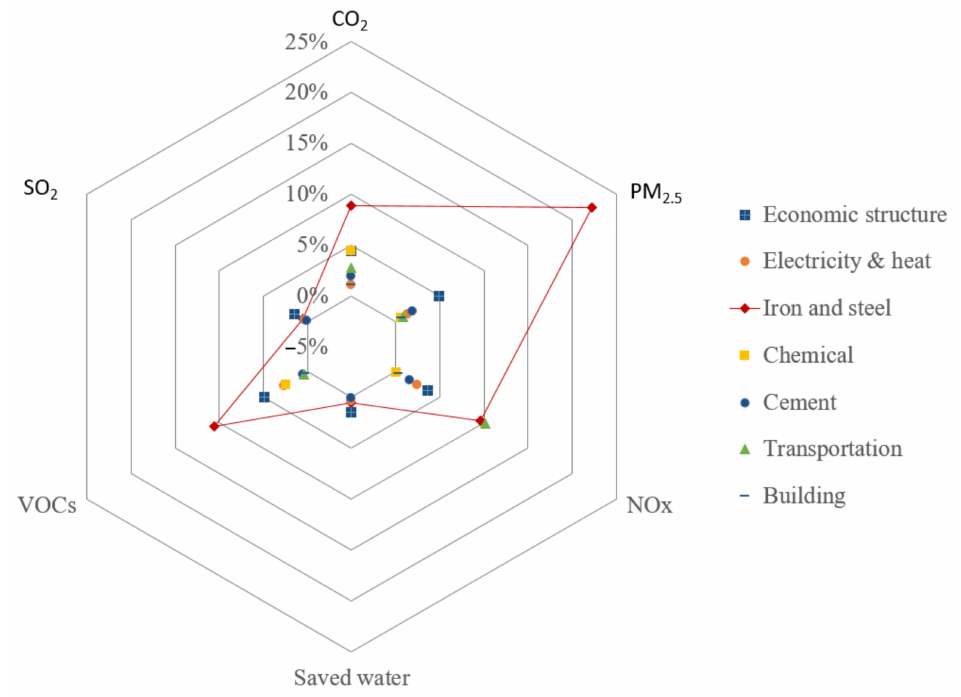
Figure 16. Sectoral reduction degree of